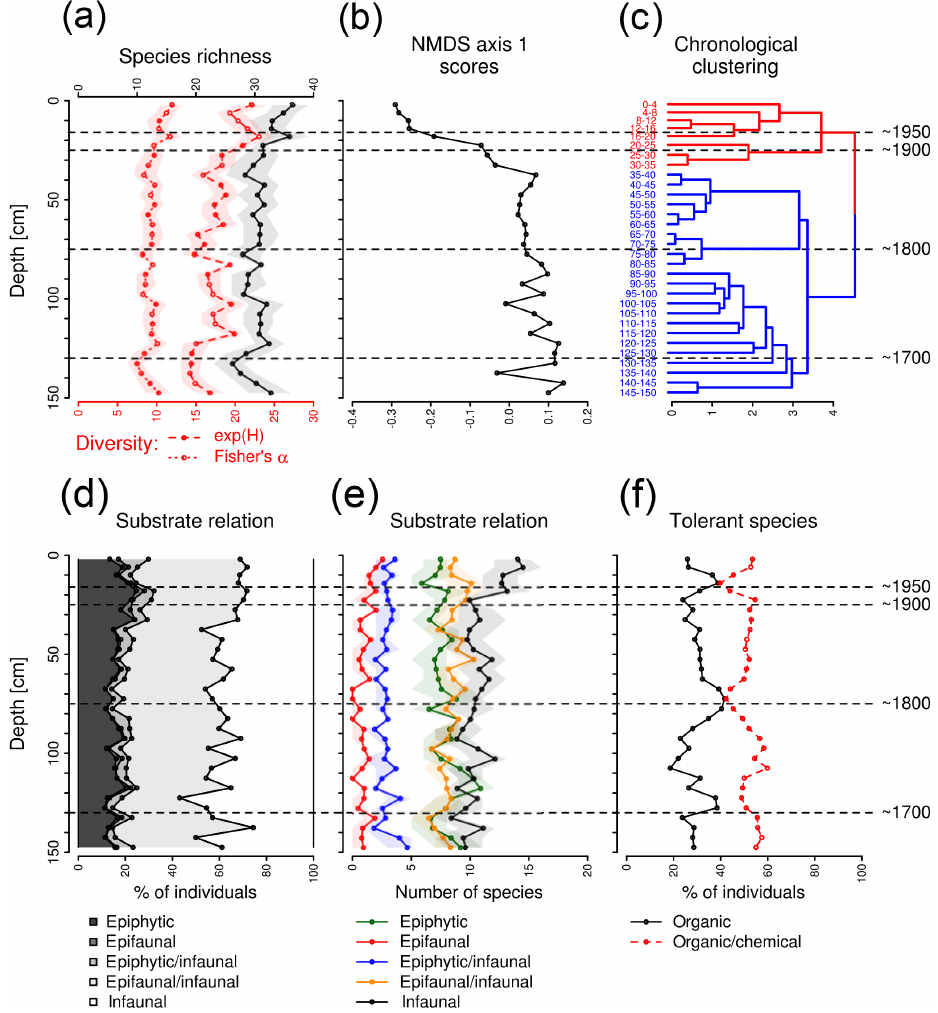
Figure 6. (a) Temporal trends in species richness, Fisher’s α index, the exponent of the Shannon index. Shown are mean values with 95% CI after rarefying to 240 individuals per sample. (b) Temporal trends in species composition summarized by NMDS axis 1 scores. (c) Chronological clustering of foraminiferal assemblages (different colors group samples separated by a major compositional shift, with the number of temporal bins determined by the broken stick model). (d) Temporal trends in the relative abundances of substrate relation groups. (e) Temporal trends in the rarefied species richness of each substrate relation group. (f) Temporal trends in the relative abundances of two foraminiferal groups according to their tolerance of different types of pollution (organic and organic/chemical). (d) to (f) are plotted based on data in Table